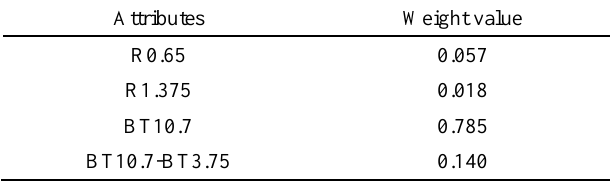
Table 7. Weight of each attribute in the model when the information entropy is used as a